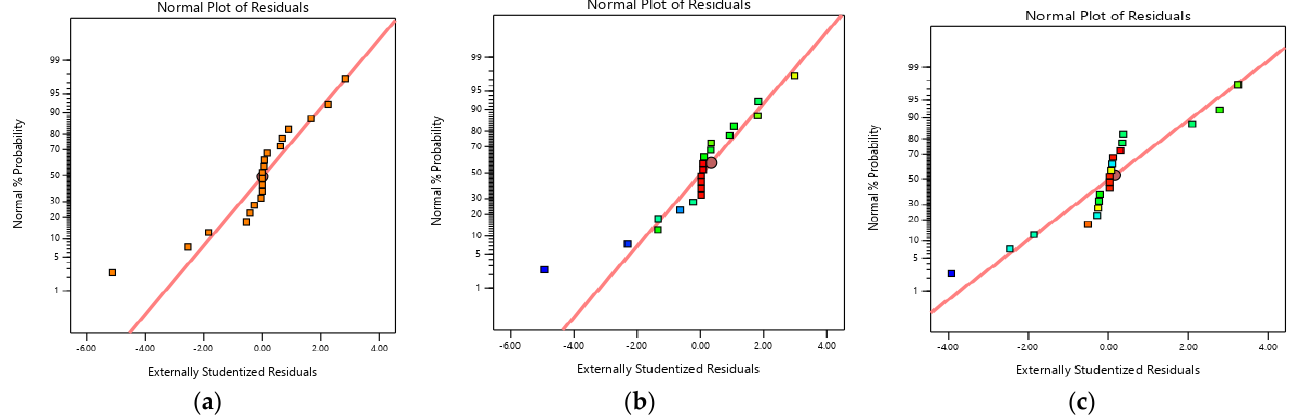
Figure 9. ( a ) Comparison of Langmuir isotherm; ( b ) Freundlich isotherm of lead adsorbed.